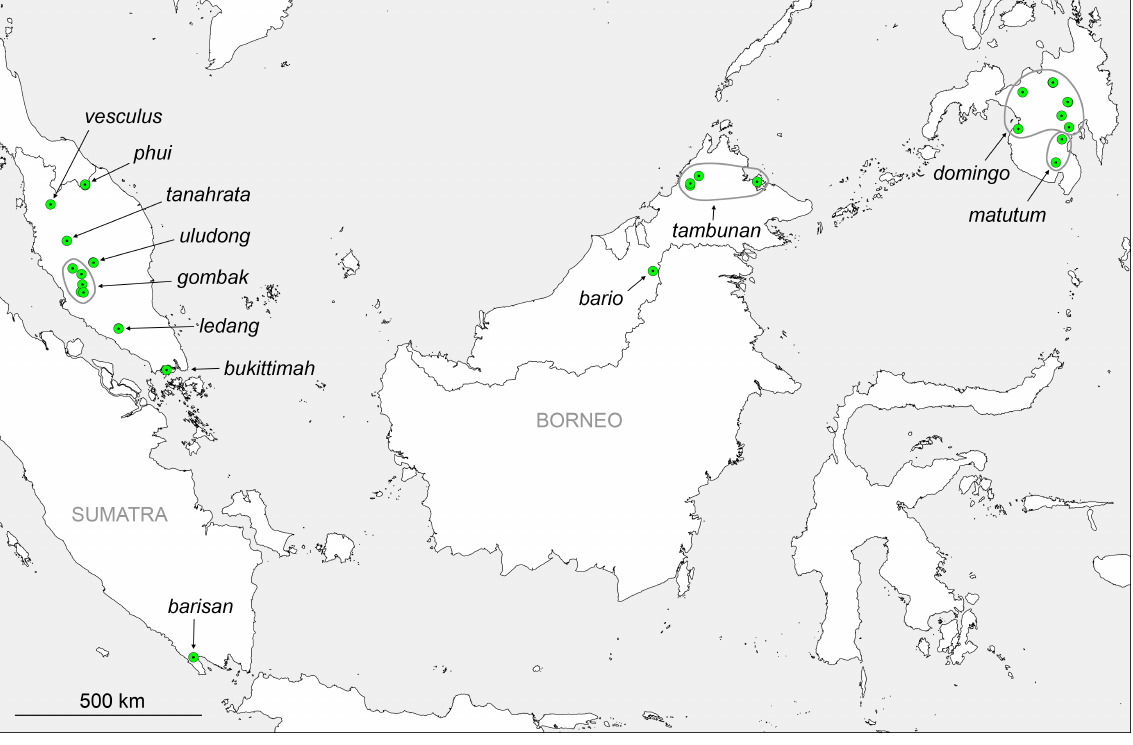
Fig. 1. Known distributions of the Pholcus ethagala group (Malay Peninsula and Sumatra; Sri Lankan species not shown), of the P. tambunan group (Borneo) and of the P. domingo group